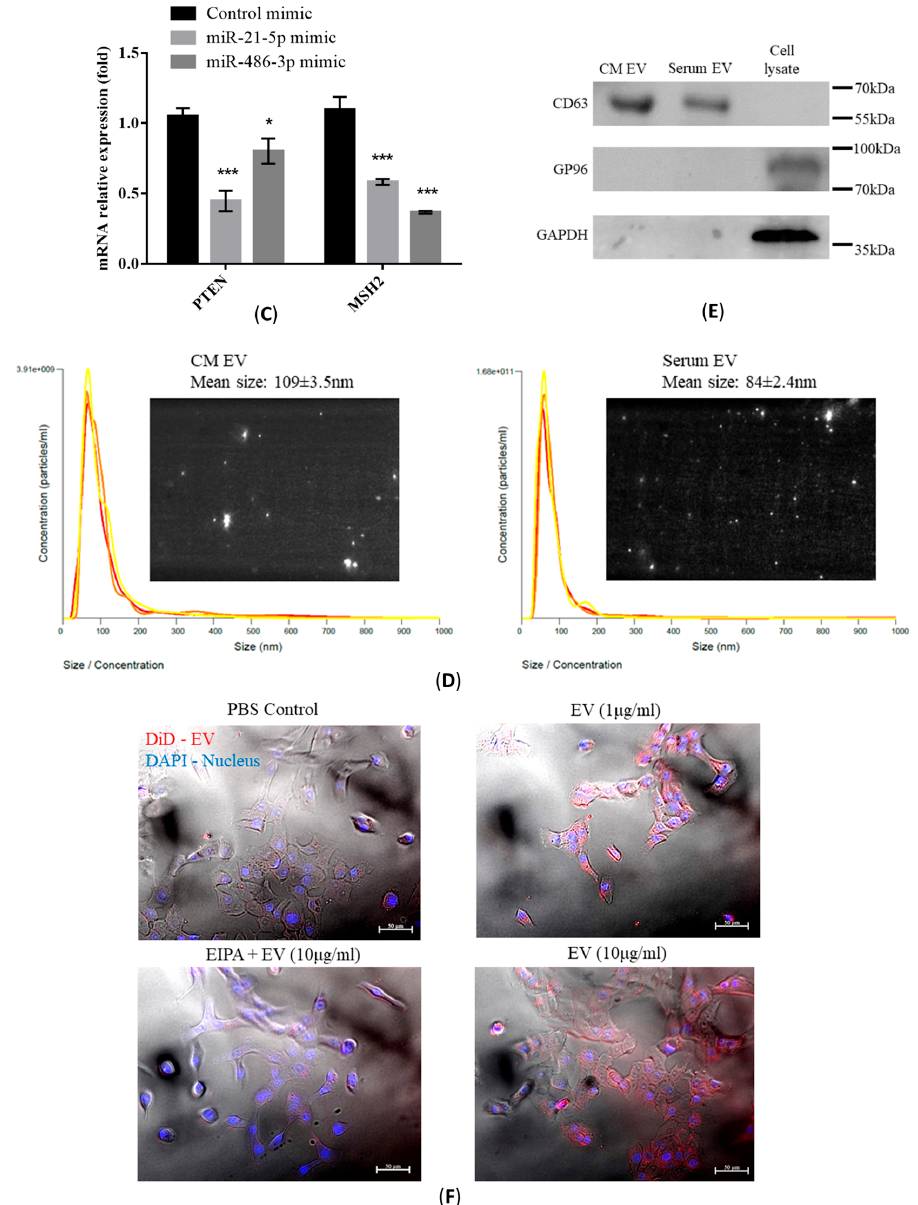
Figure 2. Profiles of intracellular and EV-associated miRNAs in FA34 resistant subclones. The ( A ) intracellular and ( B ) EV expression level of a panel of selected cancer-related miRNAs in the ALK-TKI-sensitive subclone FA34.8 and also the resistant subclones derived from FA34.5. The values are presented as mean ± S.D. from independent triplicate experiments. * p < 0.05, ** p < 0.01 vs FA34.8. ( C ) The relative expression of PTEN and MSH2 mRNA in FA34.8 transfected with miR-21-5p mimic or miR-486-3p mimic (1 nM) for 24 h. The values are presented as mean ± S.D. from independent triplicate experiments. * p < 0.05, *** p < 0.001 vs control mimic. ( D ) Characterization of EVs. Particle size analysis of EVs isolated from conditioned medium (CM) from FA34.P (left) or serum from a lung cancer patient (right). ( E ) EV protein markers CD63, and intracellular protein GP96 and GAPDH of isolated EVs from CM, serum or cell lysate were detected by immunoblot analysis with specific antibodies. ( F ) FA34.8 were incubated with DiD-labeled EVs (red) for 1 h prior to capture of fluorescent and phase contrast images (scale bar = 50 μ m).